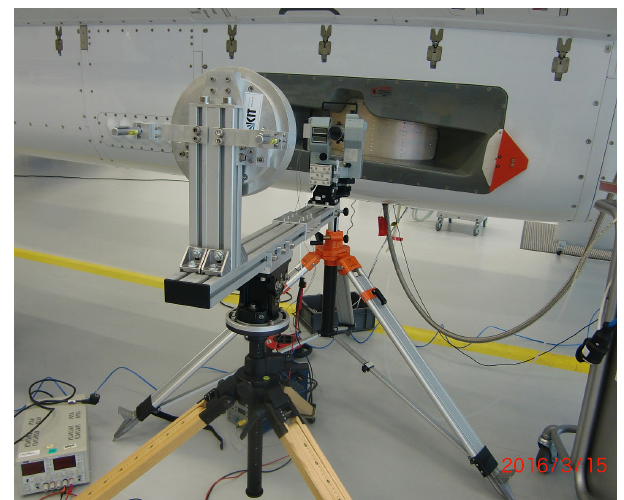
Figure 12. Pointing calibration optics with an off-axis paraboloid mirror that delivers parallel beams from a broadband infrared light source to the GLORIA instrument (gold-colored) integrated into the belly pod of HALO in Oberpfaffenhofen. During the beam adjust- ment phase, the theodolite is located between the pointing calibra- tion optics and GLORIA.